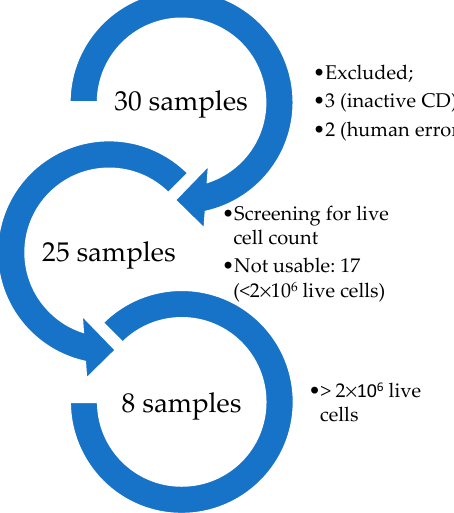
Figure 1. Setup for sample collection. Table 1. Clinical information.